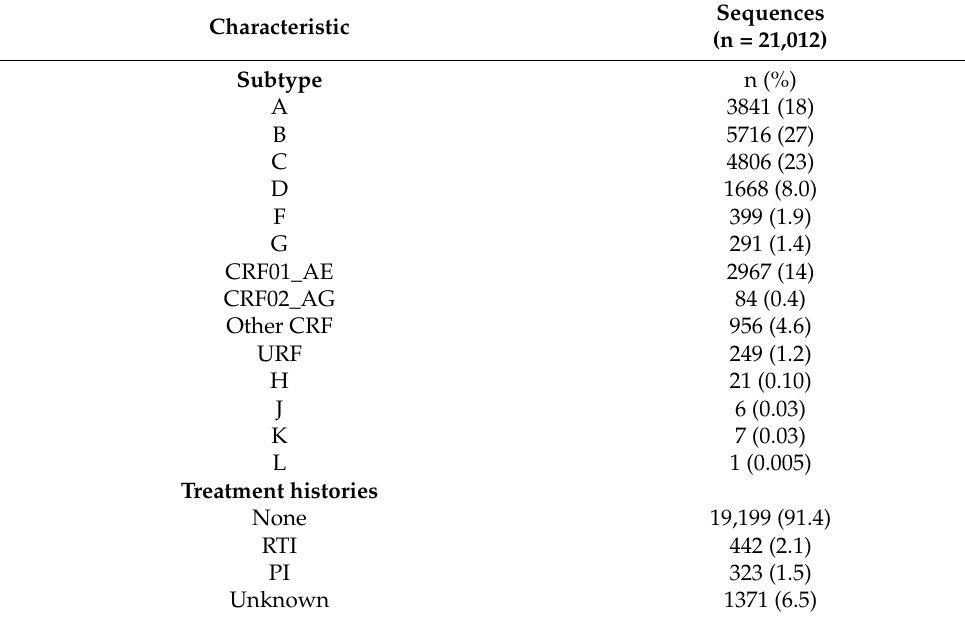
Table 1. Sequence characteristics.